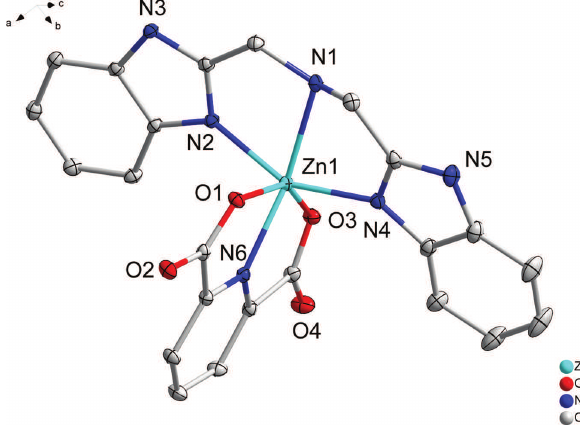
Table 1: Data collection and